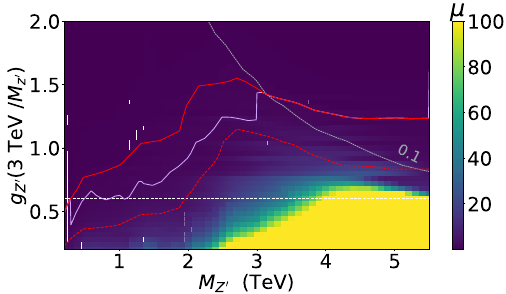
Fig. 6 μ for the CMS di-muon search [62] at each point in the scanned parameter space. The solid red line shows the contour μ = 1. The area above this is excluded at the 95% CL. The dashed red line shows our estimate of the HL-LHC sensitivity. The solid purple line shows the current observed bound from all searches considered in this work. The dashed grey line shows the contour where (cid:10)/ M Z (cid:2) = 0 . 1 , and the region between the dashed white line and the bottom of the plot is favoured by the flavour and electroweak data at the 95% CL. Toward the extreme left-hand side of the plot, our predictions become more inaccurate due / M 2 ) relative to unaccounted-for O ( M 2 Z Z (cid:2)